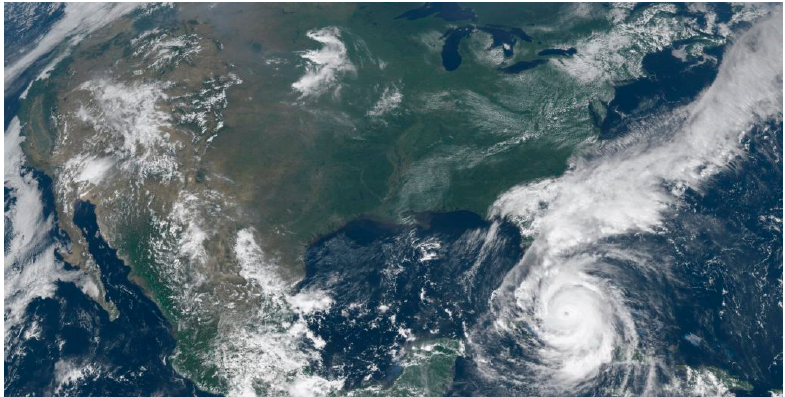
Figure 1. Meteorological satellite cloud picture.